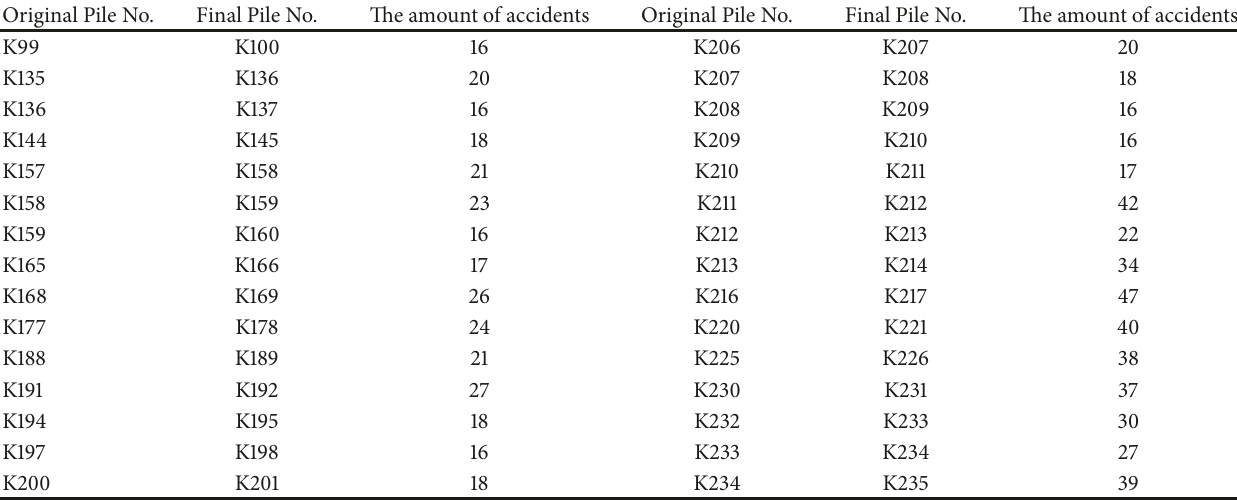
Table 2: Preliminarily select black spots.